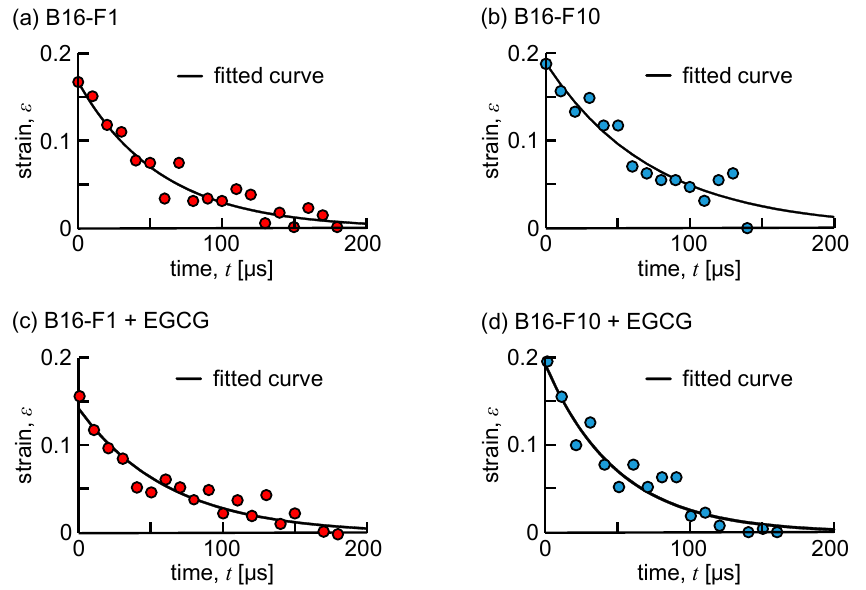
Figure 4. Time variations of the compressive strain of the cell. ( a ) Untreated B16-F1, ( b ) untreated B16-F10, ( c ) epigallocatechin gallate (EGCG)-treated B16-F1, and ( d ) EGCG-treated B16-F10.